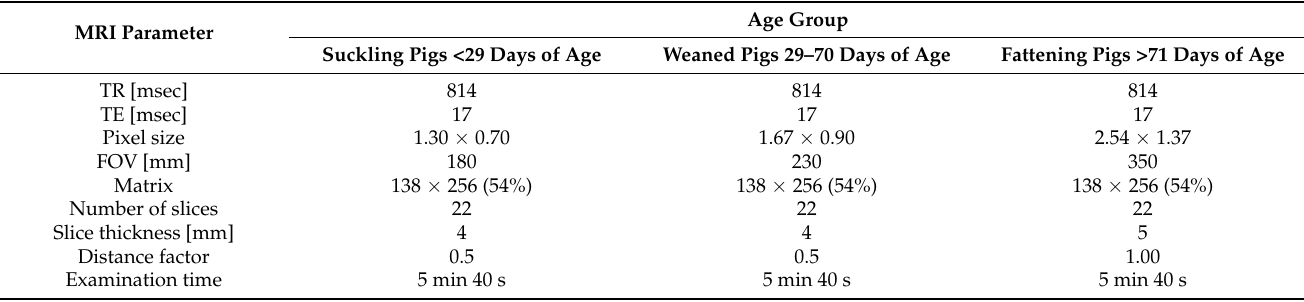
Table 2. MRI imaging